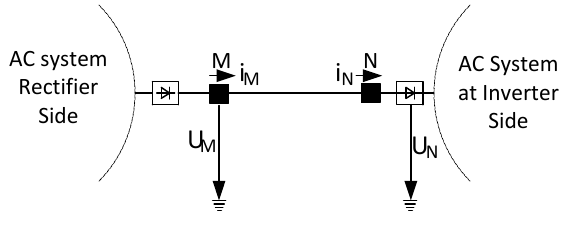
Figure 13. HVDC transmission system diagram.